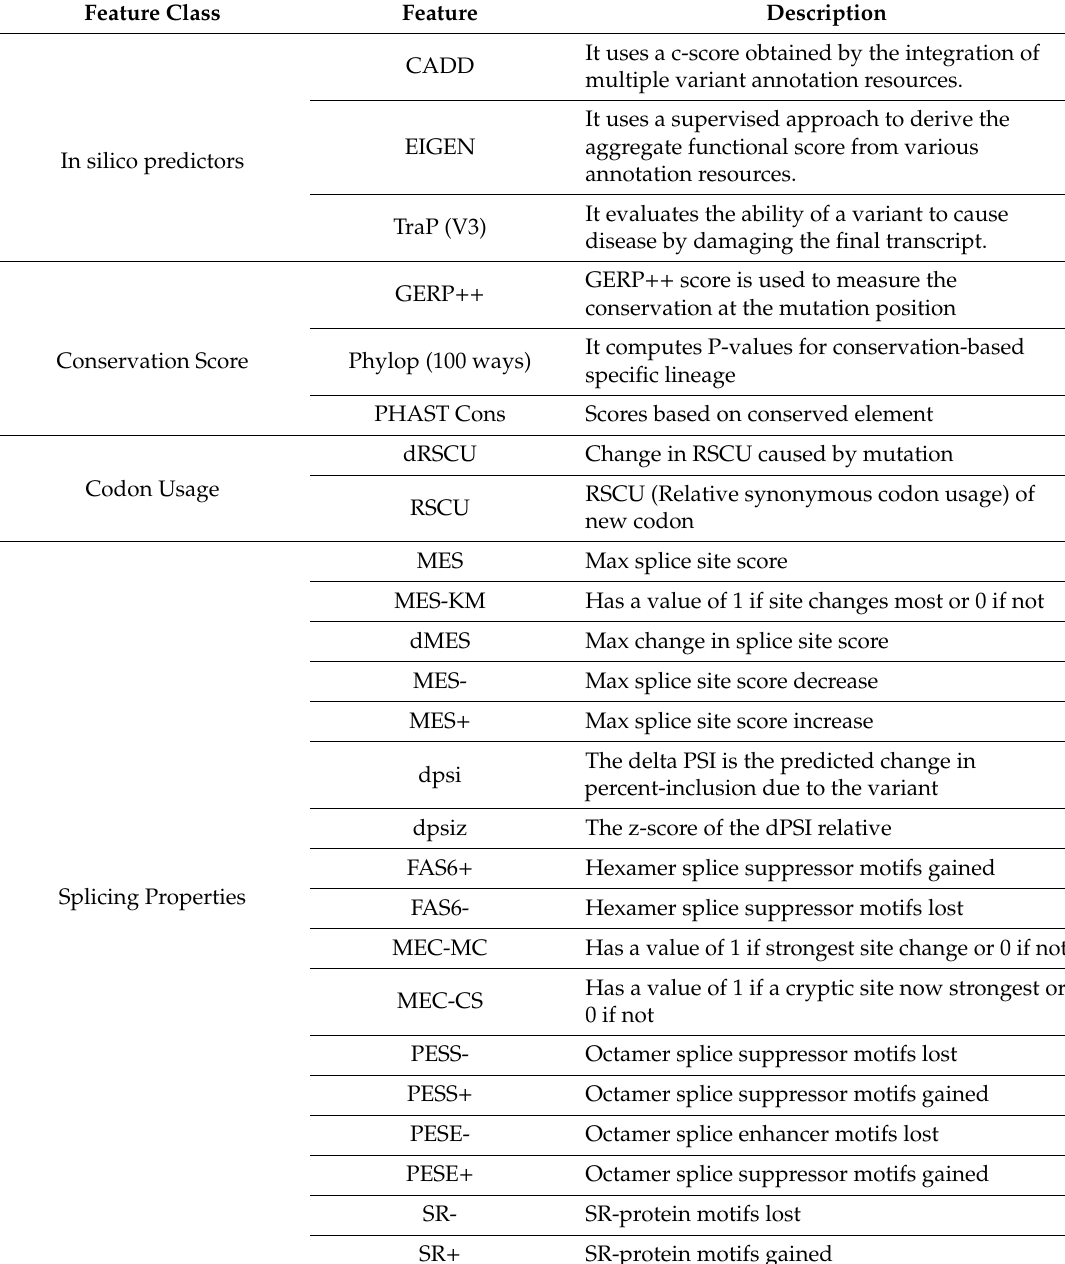
Table 1. Brief description of all the 29 features categorized into 5